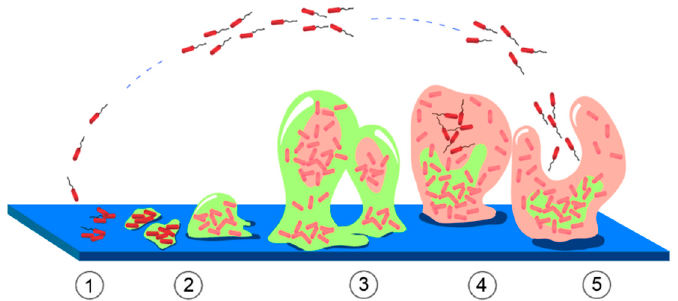
Figure 6. States of biofilm (or biofouling) formation on a material surface (based on reference [140]) State 1: reversible anchoring of bacterial colonies; State 2: bacterial colonies are irreversibly anchored to the surface; State 3: maturation; State 4: the maturation phase is completed and State 5: the bacterial colonies begin to move again, dispersing in microcolonies.